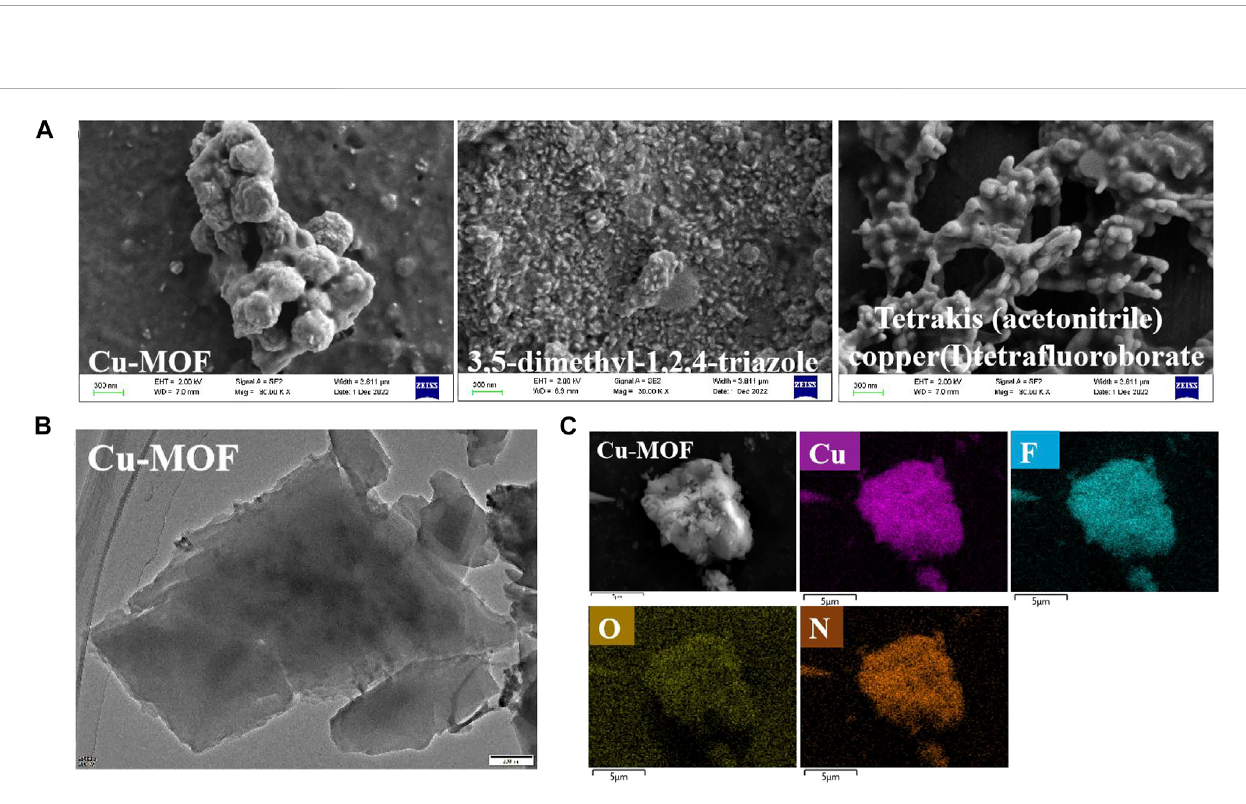
FIGURE 2 (A) SEM images of different powder samples of Cu-MOFs, 3,5-dimethyl-1,2,4-triazole and tetrakis (acetonitrile) copper (I) tetra fl uoroborate powder, respectively, (B) TEM and (C) SEM images of Cu-MOFs with element mapping